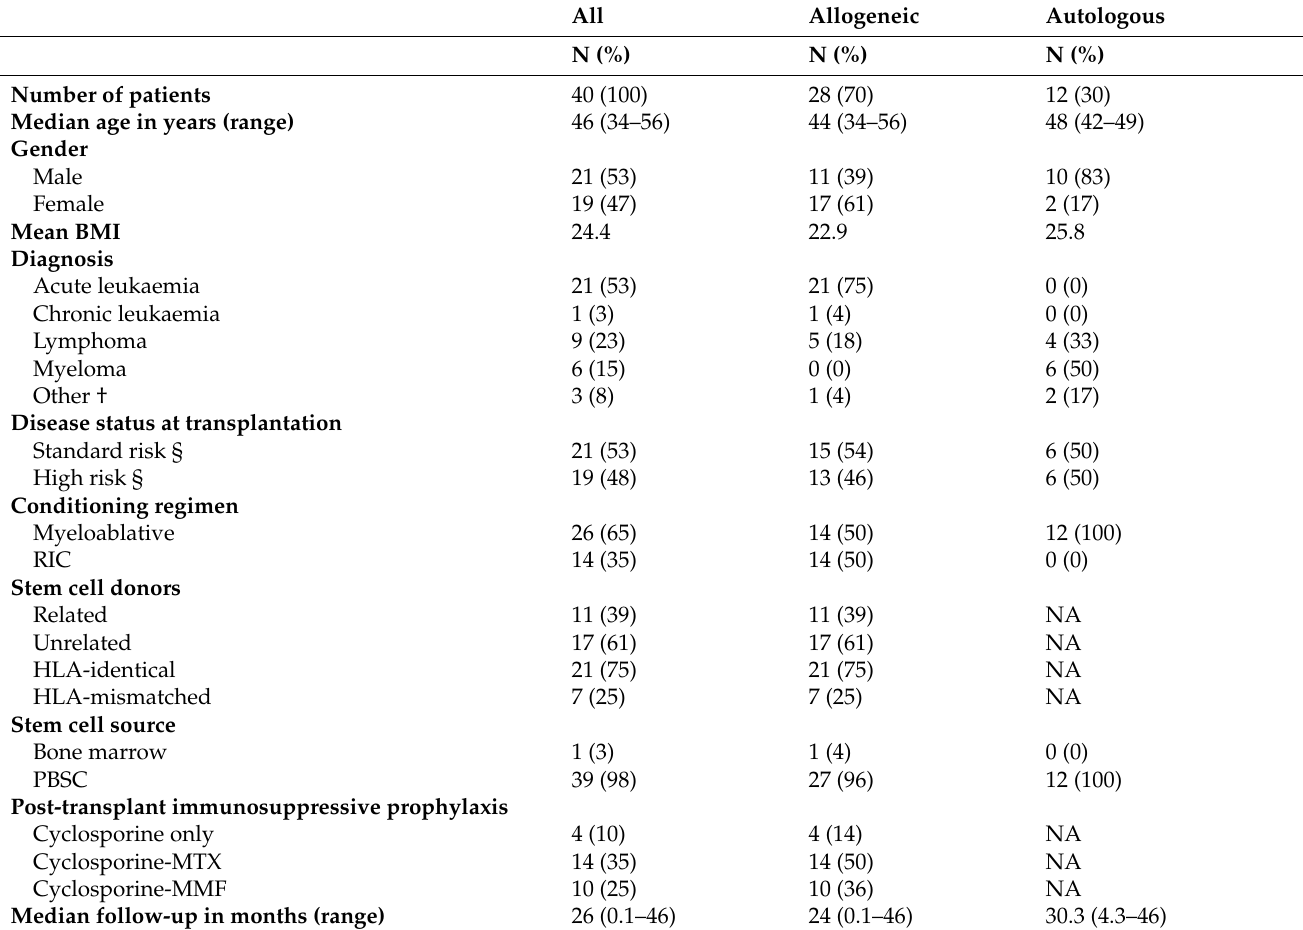
Table 1. Demographic data of allogeneic and autologous patients.